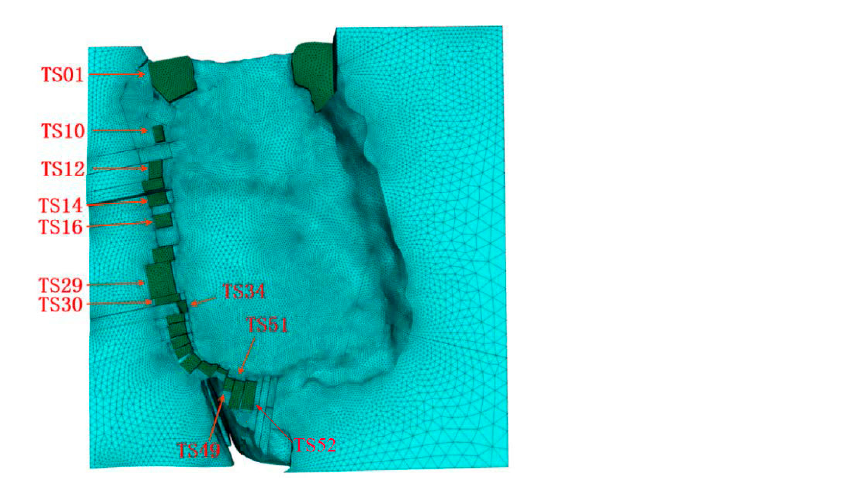
Figure 16. Distribution of the location of the current cracked and damaged boulders. To analyze the influence of different degrees of damage on the stability of the roof plate of Yuanjue Cave, the mechanical parameters such as the modulus of elasticity of the cracked damaged slates were reduced to 1/2, 1/5, 1/10, 1/50, and 1 × 10 − 6 of the original ones (where 1 × 10 − 6 can be equated to complete damage). The overall equivalent stiffness of each group of slates was calculated, and the results are shown in Table 4 (only the slates with changed equivalent stiffness are listed). Table 4. Equivalent bearing stiffness of the cracked boulders. Damage